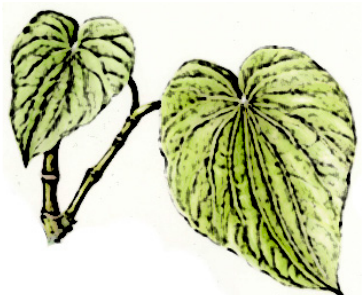
Figure 1. Kava Figure 1. Kava leaves.